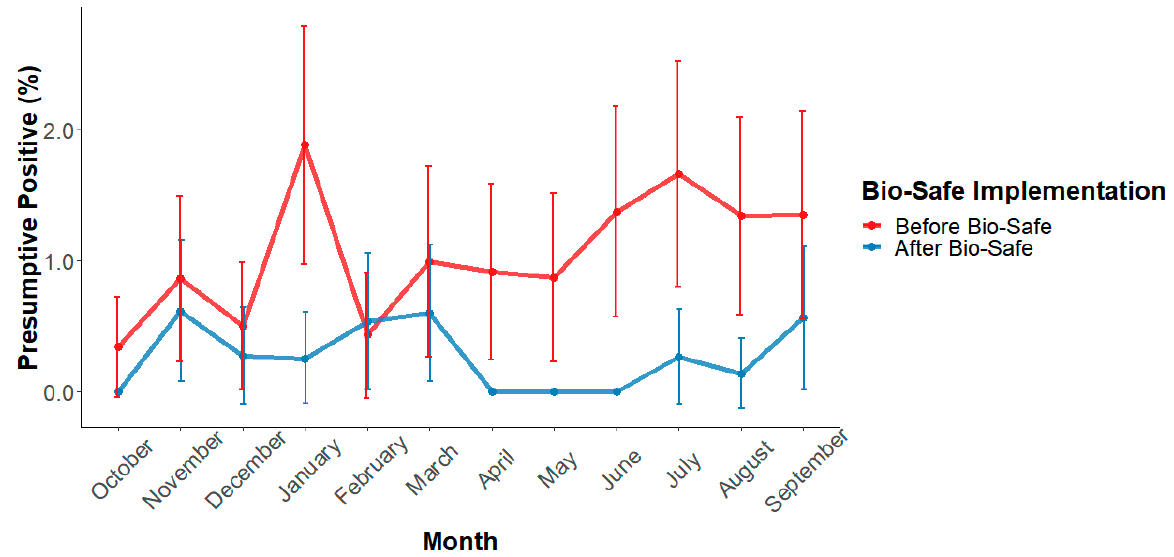
Figure 4. In-plant monthly Presumptive positive rate of E. coli O157:H7 in beef trim before and after implementation of the ozone intervention (N = 19,048). ɪ Error bars represent 95% confidence intervals of the monthly incidence.